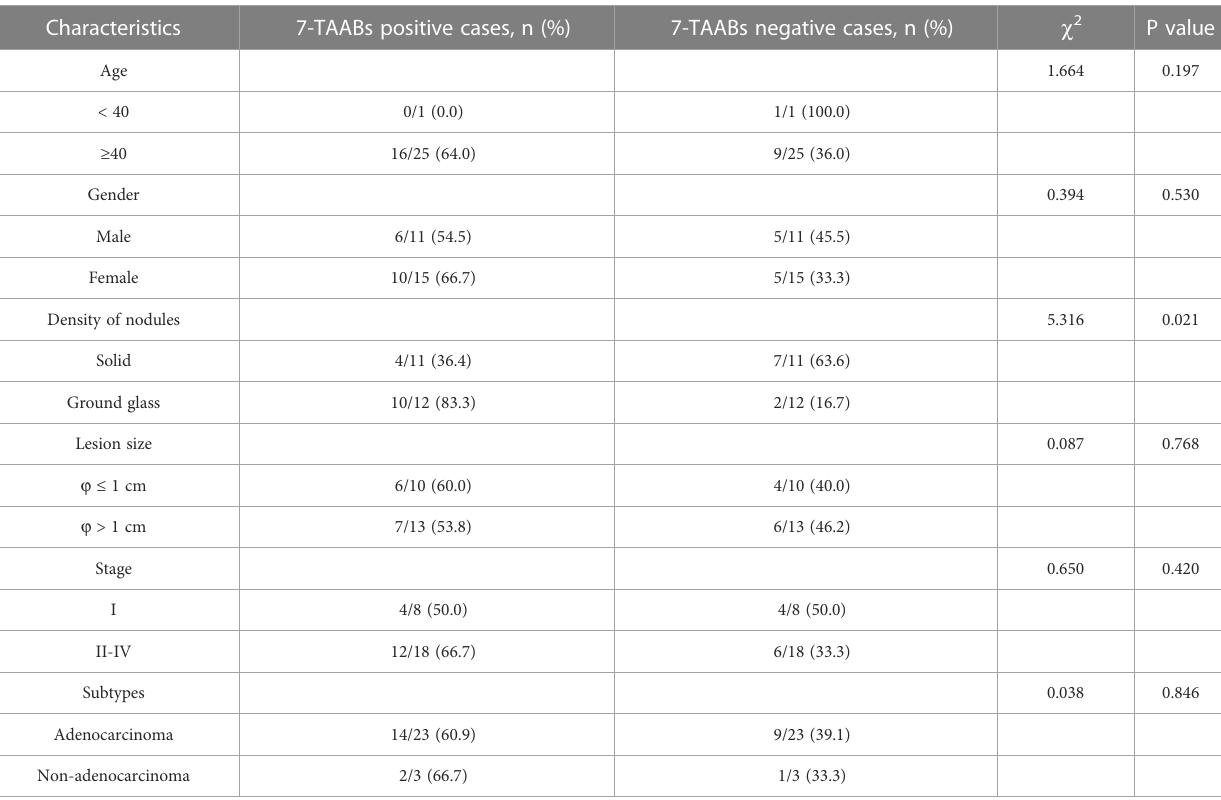
TABLE 4 Comparison of the clinical characteristics of the lung cancer patients with different 7-TAAB responses.